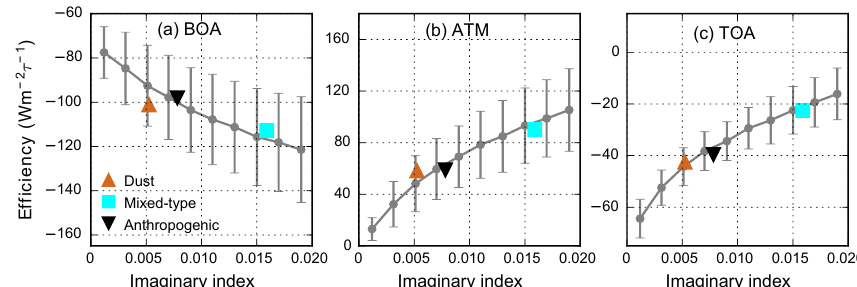
Figure 9. Direct aerosol radiative efficiency as a function of imaginary refractive index for the dust, mixed-type, and anthropogenic aerosols: (a) BOA, (b) ATM, and (c) TOA.